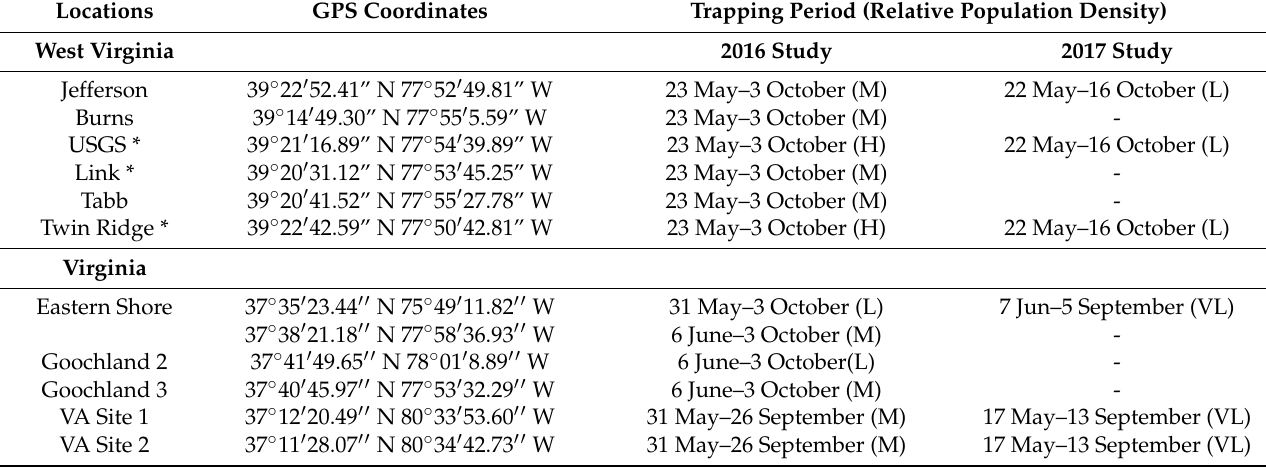
* Indicates sites with yellow sticky cards baited with Tr é c é low rate lures in comparison with clear sticky and pyramid traps from the week of 26 June to 3 October 2016. Population Density: “VL”: Very Low, “L”: Low; “M”: Moderate, “H”: